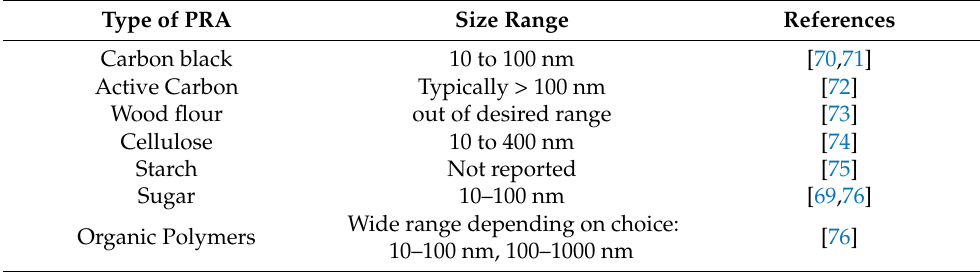
Table 7. Use of pore-regulating agents in